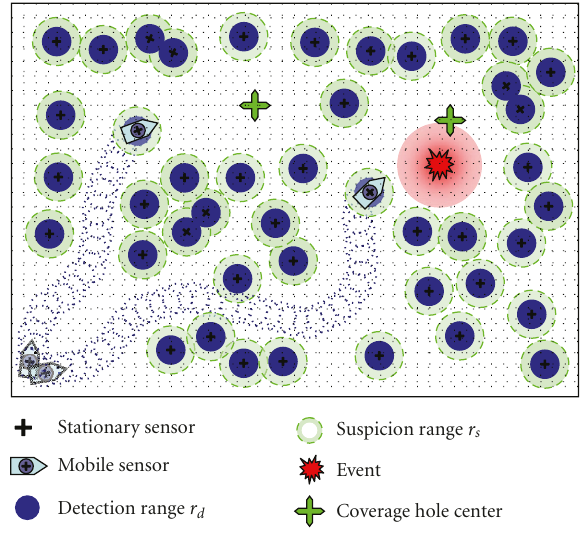
Figure 1: Environment